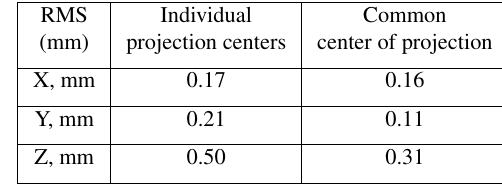
Table 3. Results of photogrammetric processing of the